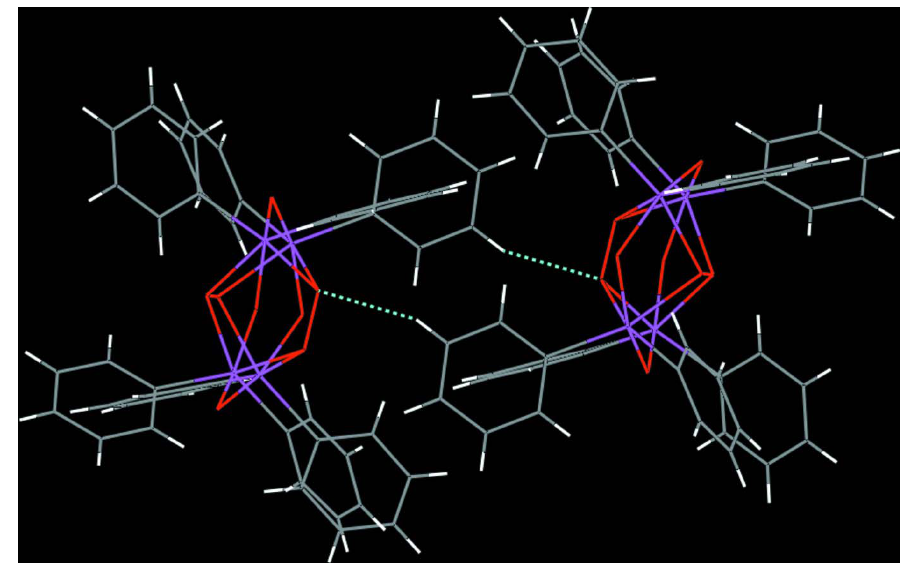
Figure 2 Centrosymmetric dimers in the crystal structure of the title compound, formed by H23···O412 contacts ( cf. Table